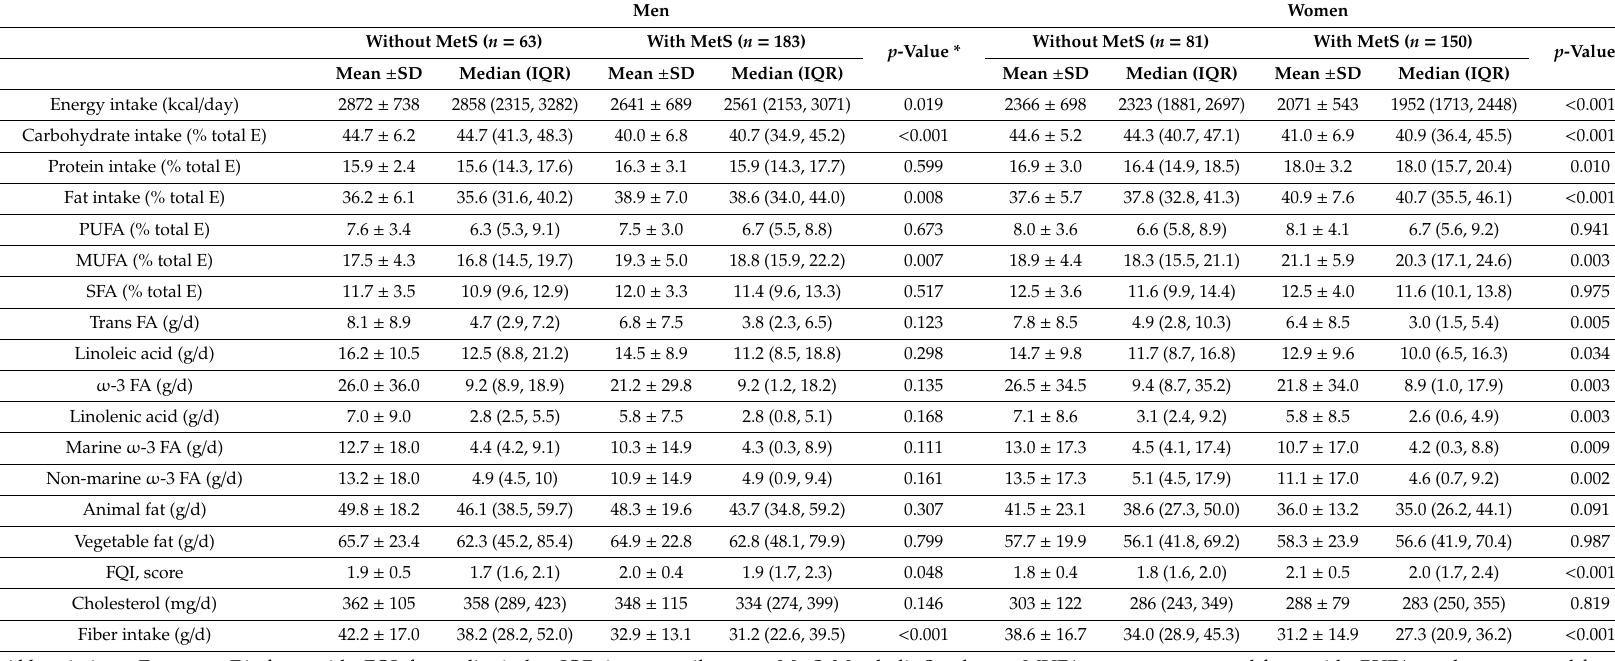
Table 2. Nutrient intake in participants “with Metabolic Syndrome” ( n = 333)and “without Metabolic Syndrome” ( n = 144) stratified by sex. Men Women Without MetS ( n =